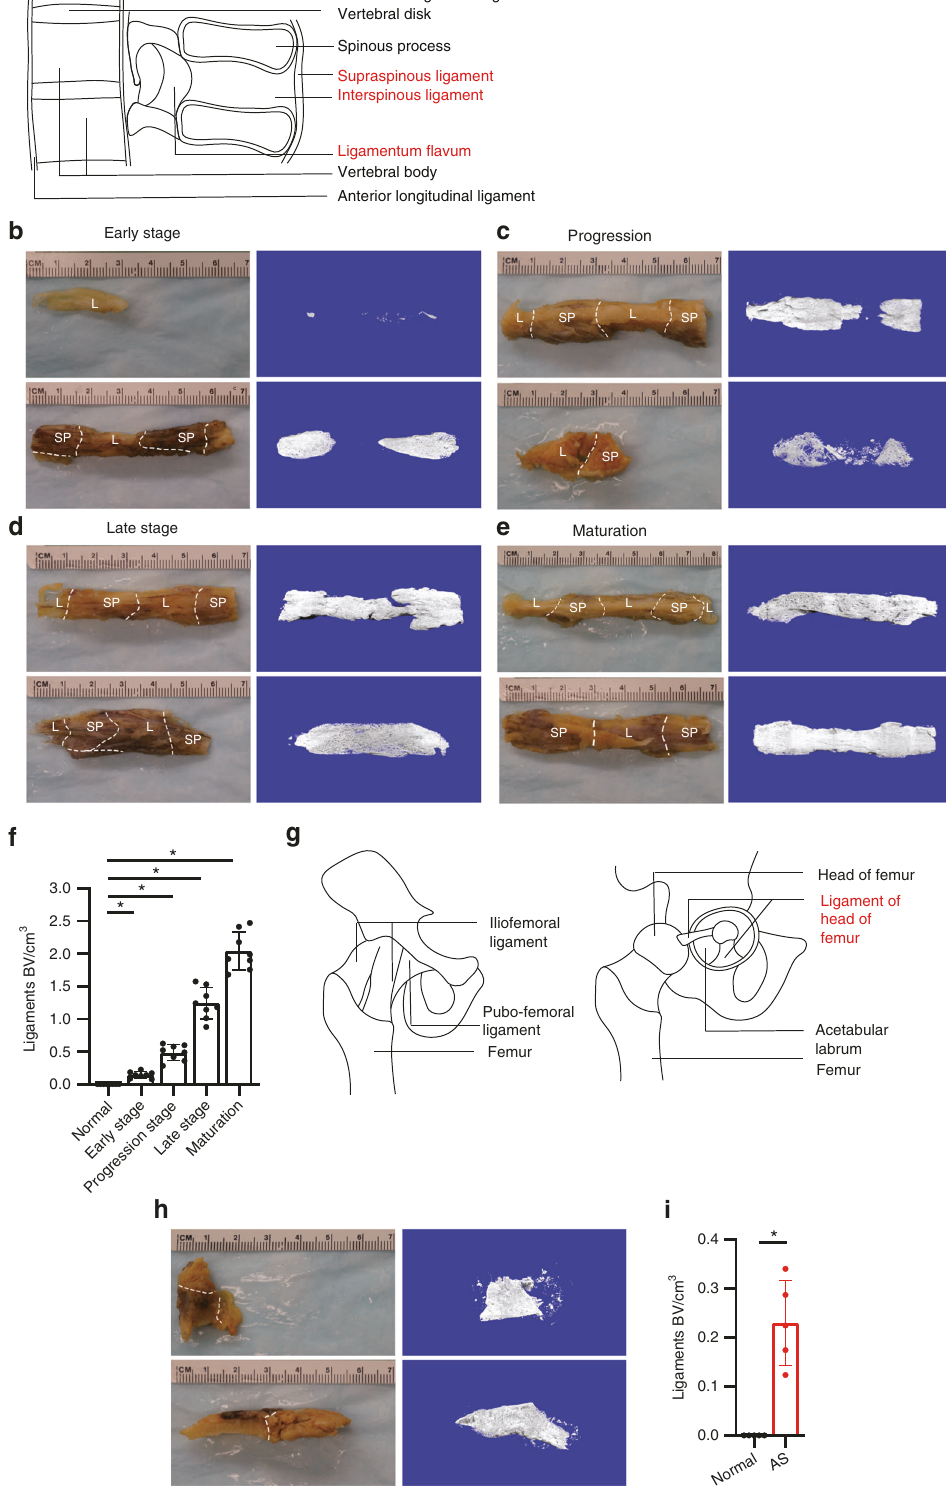
Fig. 1 μ CT scan of calci fi ed ligaments in AS patients. a Illustration of spinal ligaments. Unaided views of spinous process specimens (interspinous ligament with supraspinous ligament and/or ligamentum fl avum) and their μ CT scans showing b limited calci fi cation, c partial calci fi cation, d complete calci fi cation of ligaments, and e mature bony ligaments. f Quanti fi cation of heterotopic bone volume (BV) in ligaments of the spinous process. g Illustration of hip joint ligaments. h Unaided view of calci fi ed ligaments of a hip joint specimen and its μ CT scan. i Quanti fi cation of heterotopic bone volume in ligaments of the hip joint in normal and ankylosing spondylitis (AS) specimens. L, ligament; SP, spinous process; AL, acetabular labrum; FH, femoral